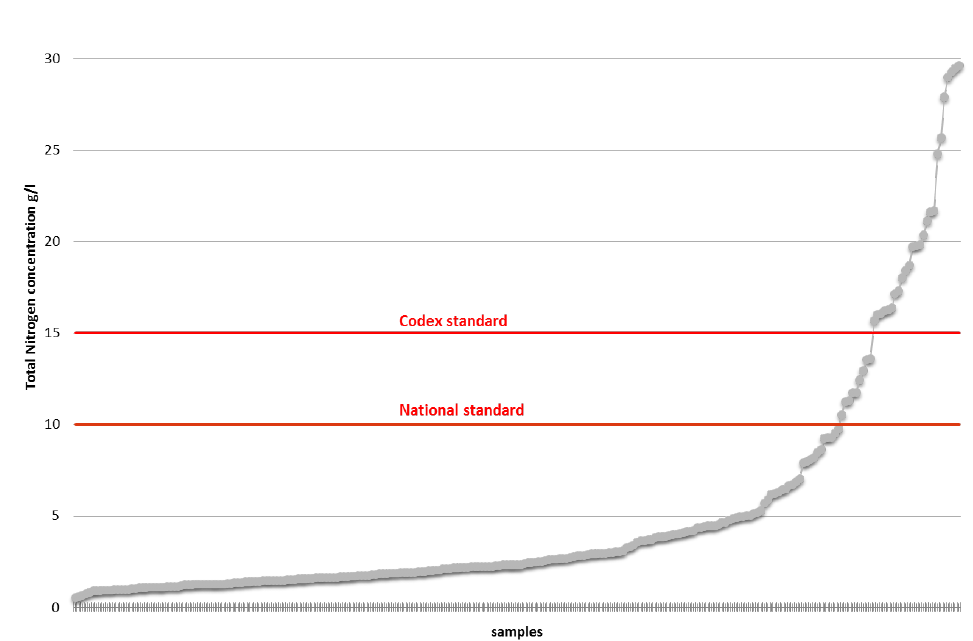
Figure 3. Nitrogen values (g/L) in fish sauces (sorted by lowest to highest salt value).